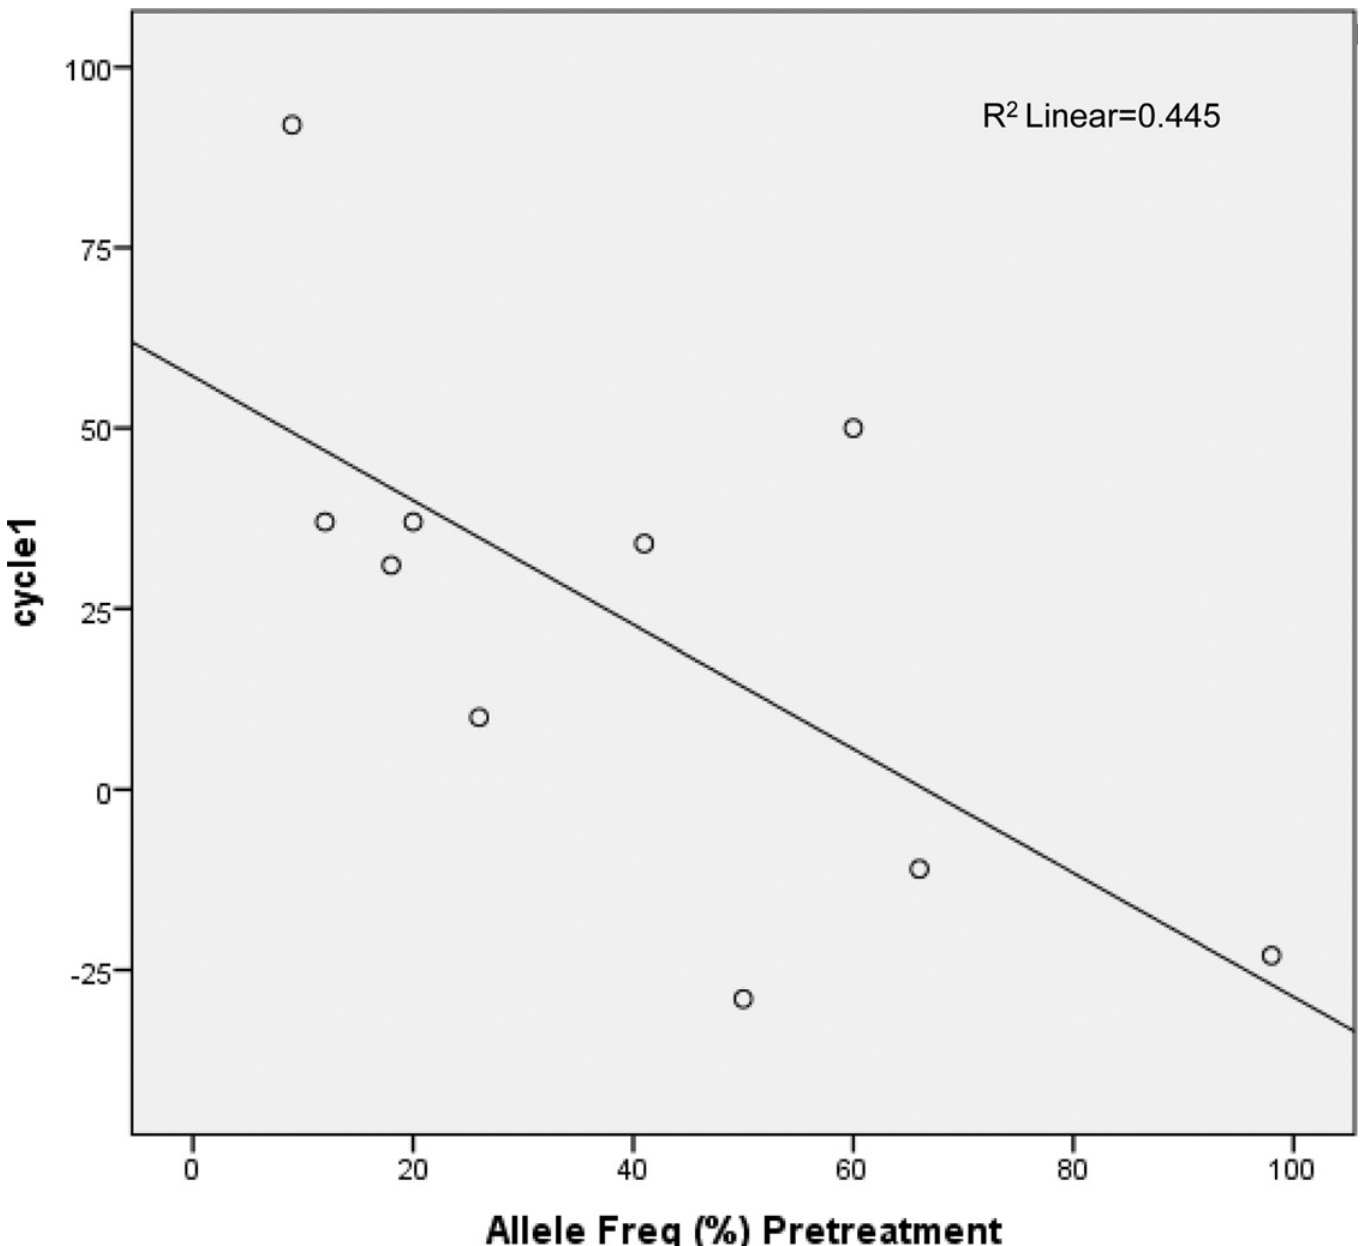
Fig 3. Correlation between percentage allele frequency and post-cycle 1 tumor response of at least